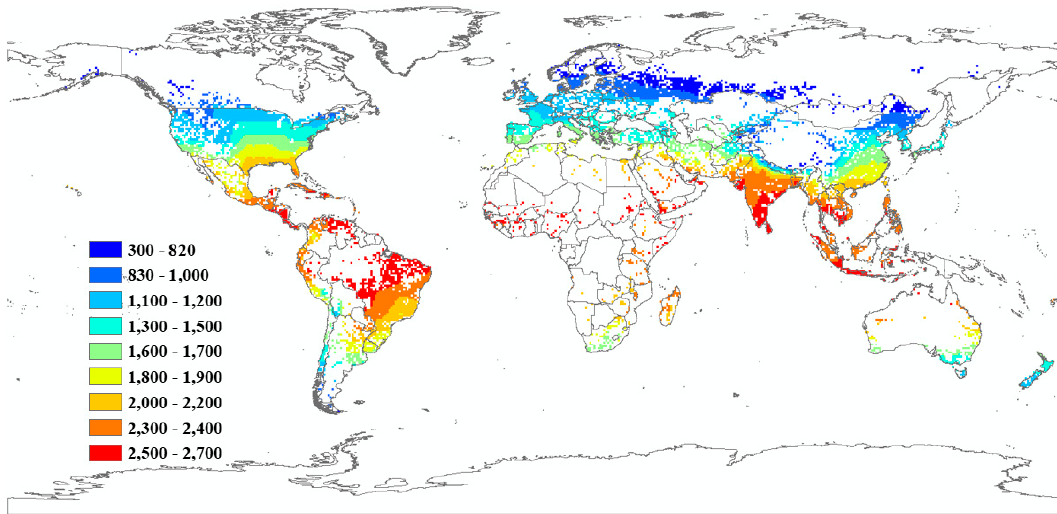
Figure 10. Net irrigation water requirement of MIROC5 model in 2050 (RCP8.5). The same irrigated area than in 1960 is used the same in Figure 1.